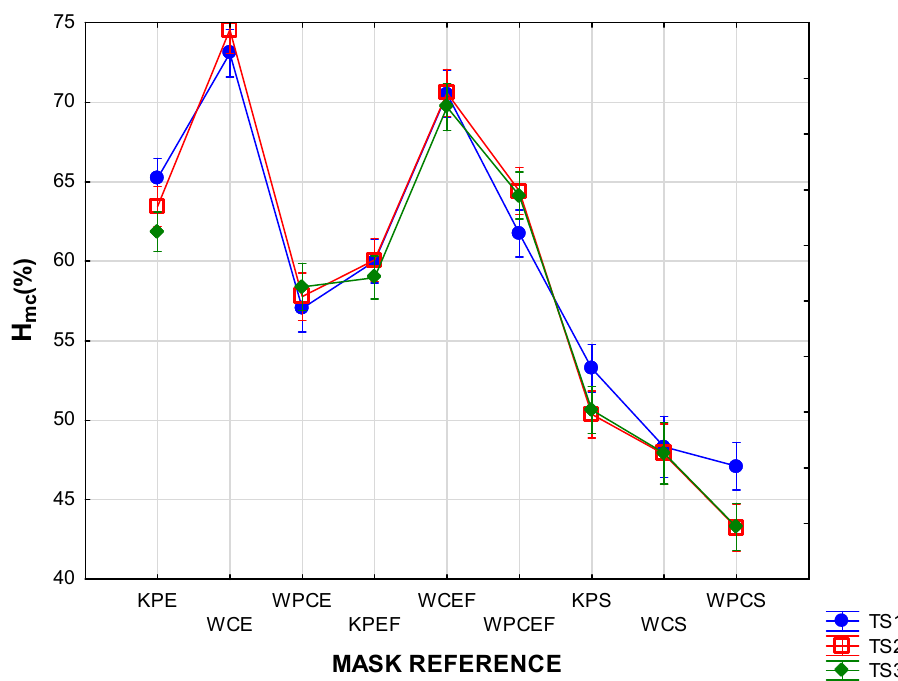
Figure 10. Two-way ANOVA of H mc per time segment according to mask design (referenced as explained in Table 1).